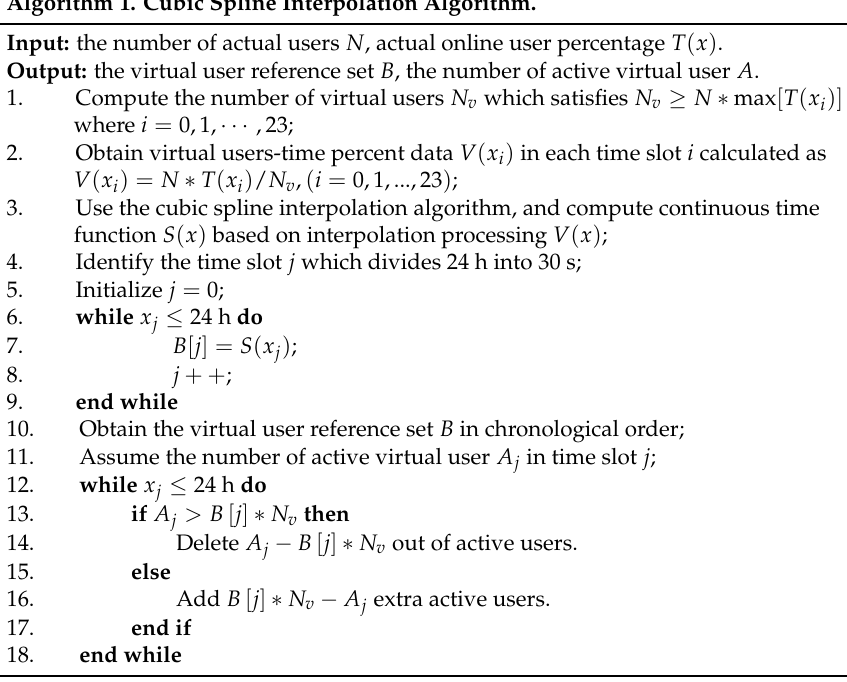
Table 1. The numbers of users versus time curve, processed by Cubic Spline Interpolation. Algorithm 1. Cubic Spline Interpolation